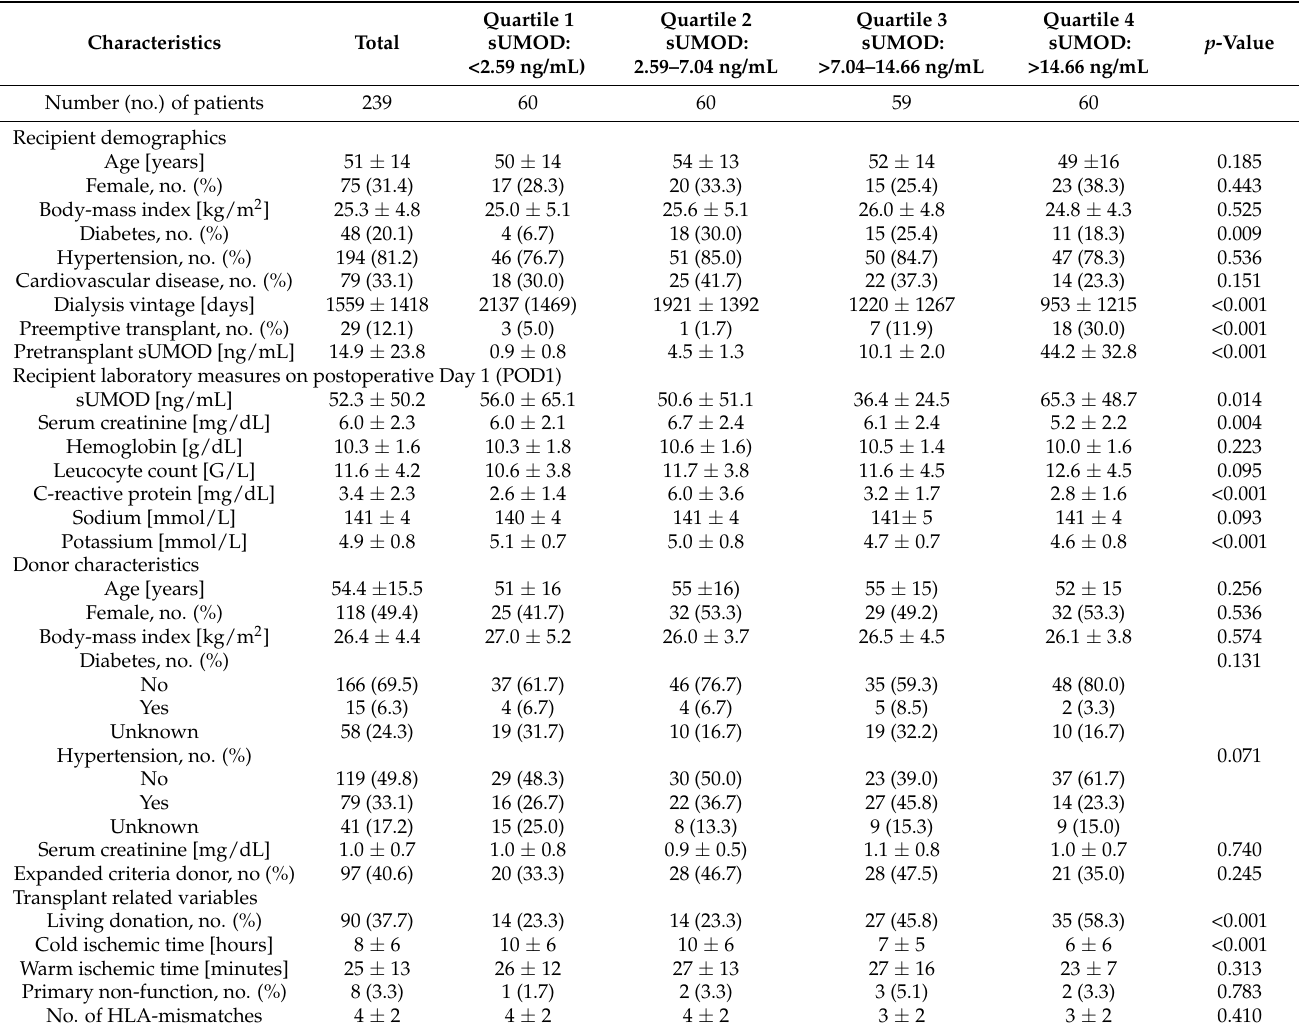
Table 1. Overall baseline characteristics (n = 239) and baseline characteristics of participants stratified by quartiles distributed according to pretransplant serum uromodulin (sUMOD).